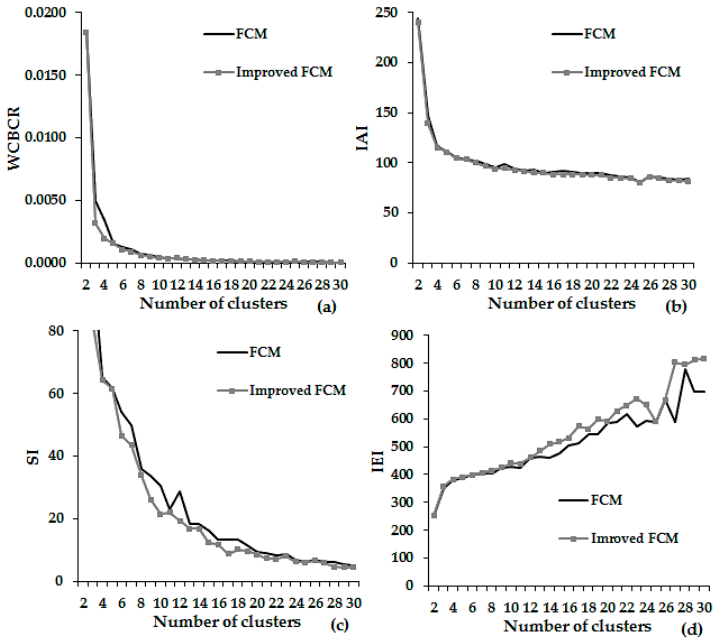
Figure 6. Comparison of the algorithms considering: ( a ) WCBCR; ( b ) IAI; ( c ) SI and ( d ) IEI indicators on the average data set of consumer 1. Energies 2017 , 10 , 1407 19 of 41